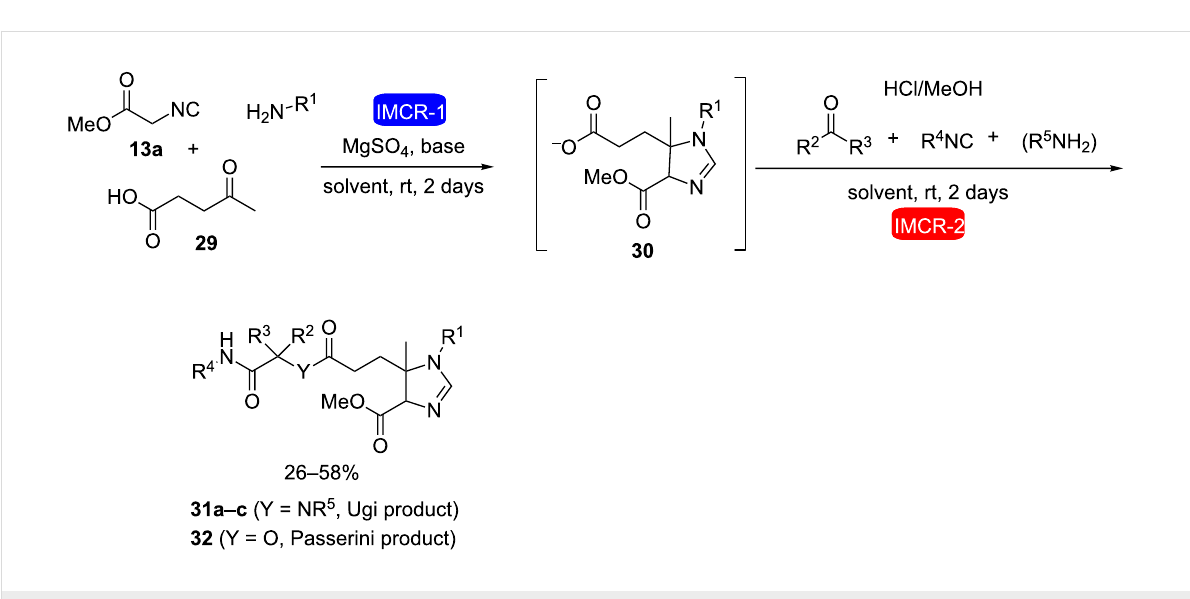
Scheme 8: Combination of IMCRs for the synthesis of substituted 2 H -imidazolines